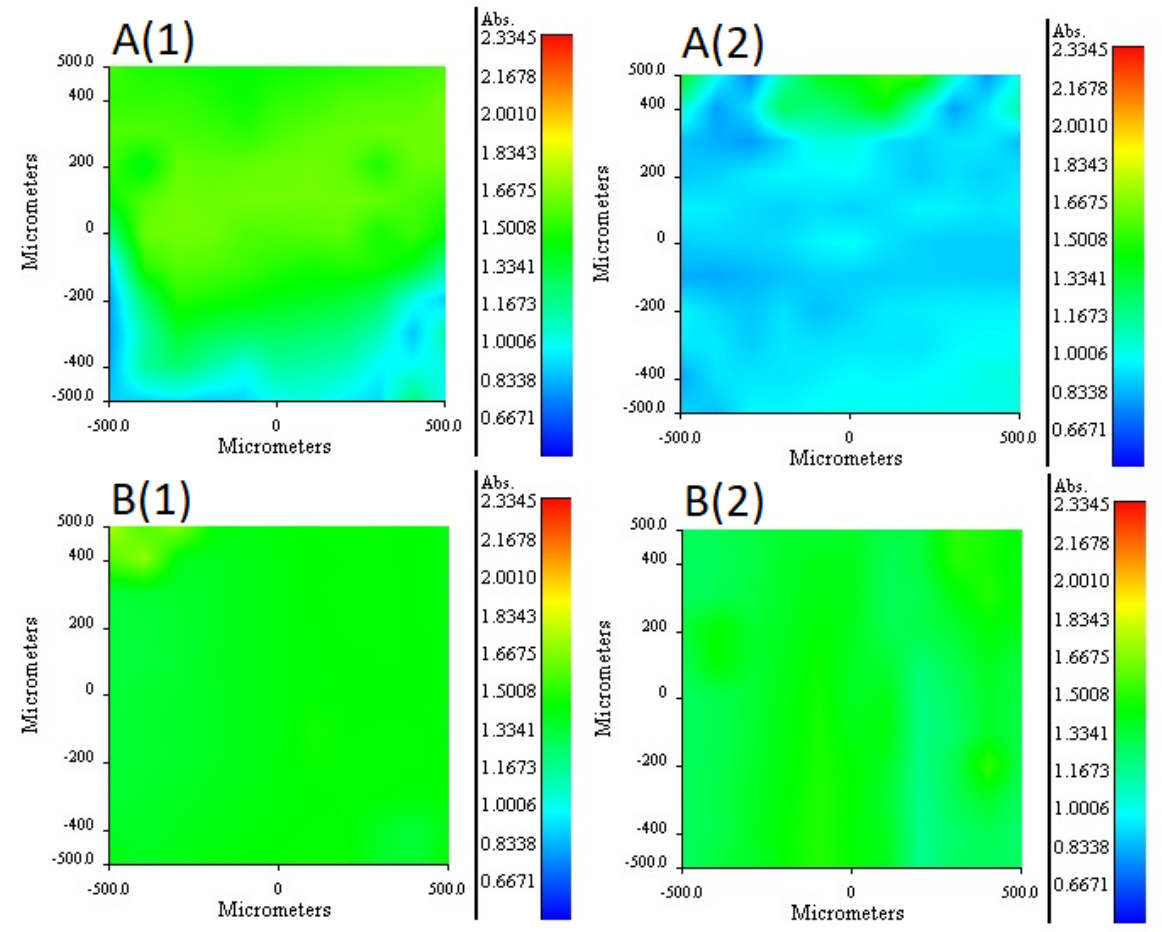
Figure 7. RIMM maps monitoring the distribution of TBEP in PIM m7 ( A ), and TBEP in PIM m9 ( B ). (1) stands for face 1 and (2) for face 2 of the PIMs (see text).